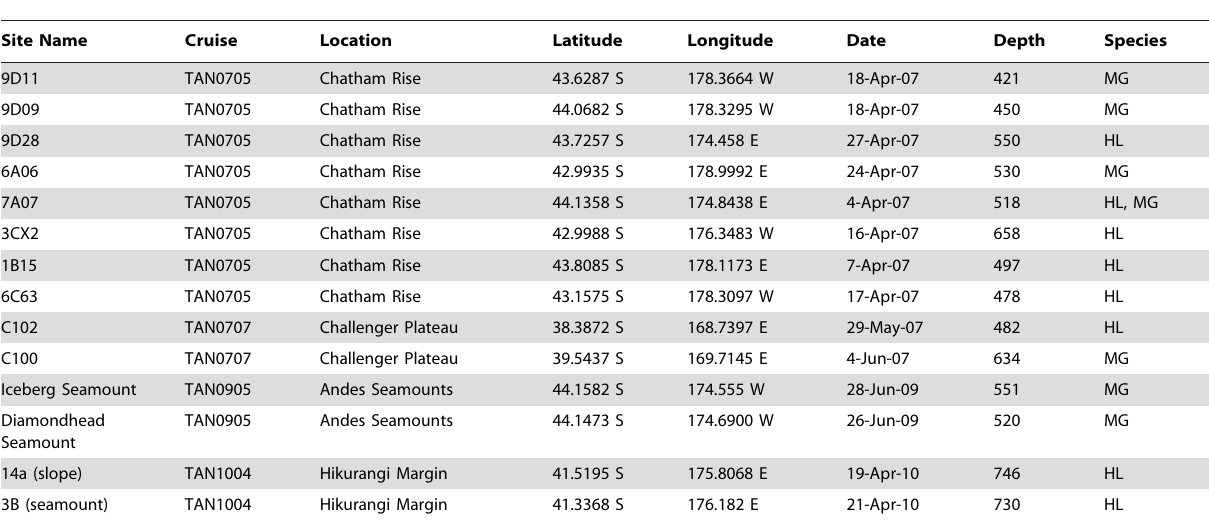
Table 1. Sites and collected samples included in this